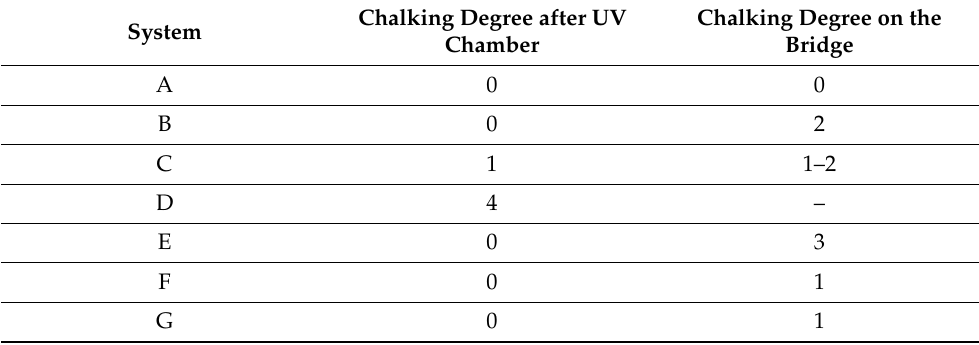
Table 6. Comparison of chalking degree between the coatings after 1000 h exposure in a UV chamber and coatings on bridge